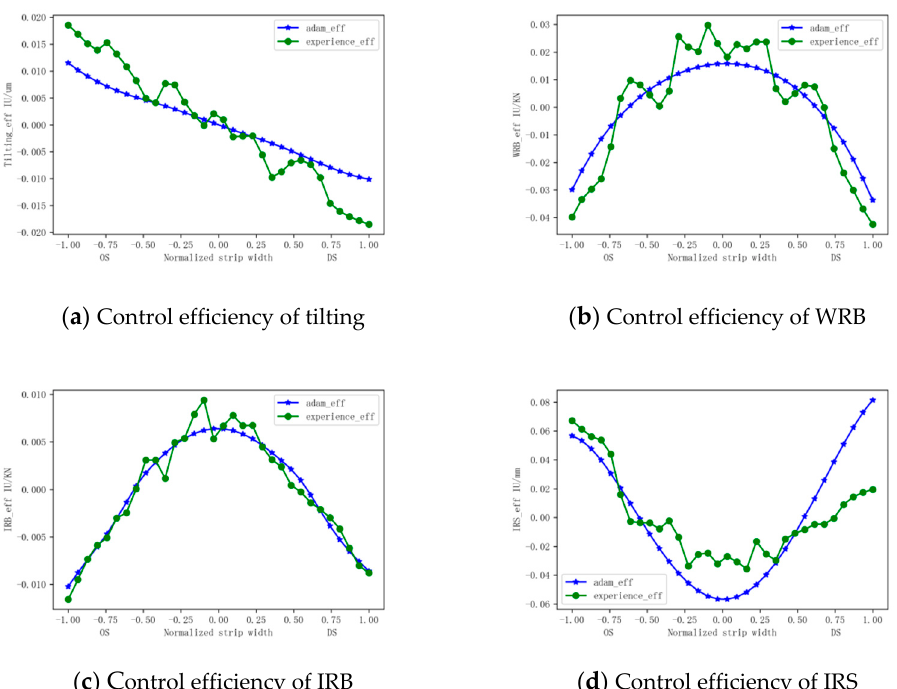
Figure 7. Comparison of the two control efficiencies.